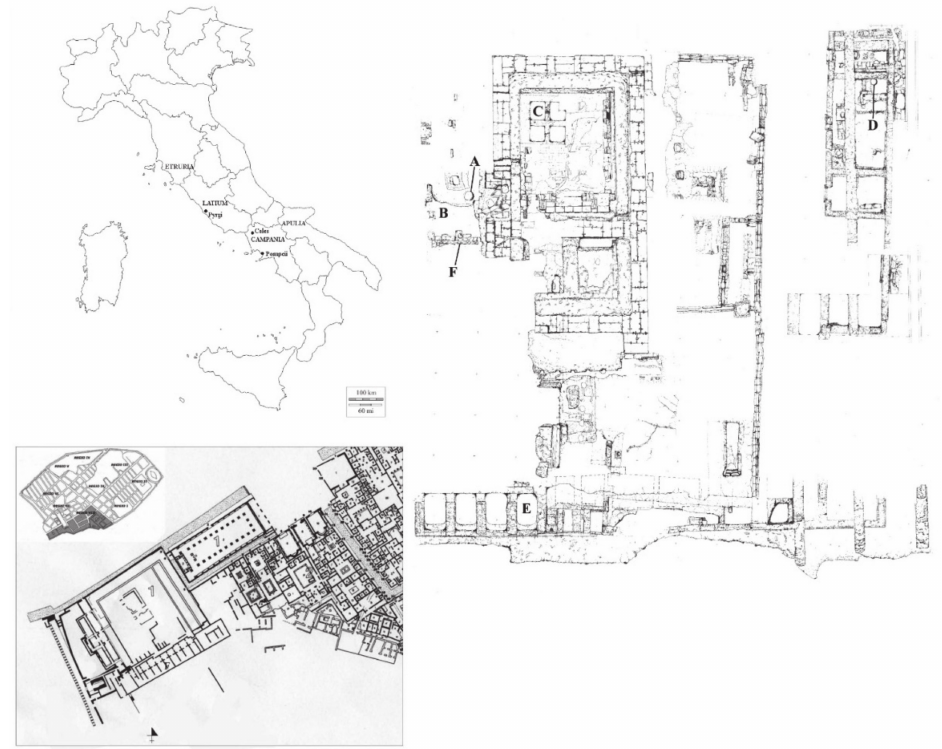
Figure 1. Map of main production sites ( top left ), localization of the Temple of Venus Fisica ( bottom left ) and map of the archaeological site ( top right ). B is identified as the place where the analyzed samples of black-gloss ware and bucchero come